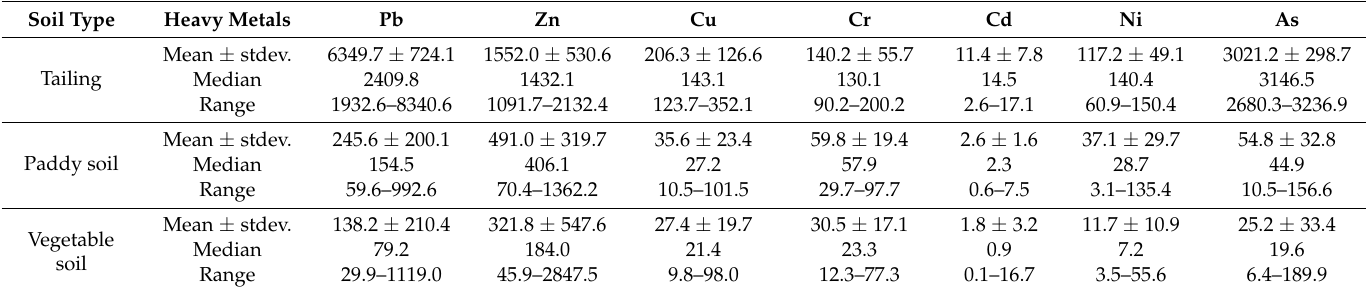
Table 4. Heavy metal concentrations in soils